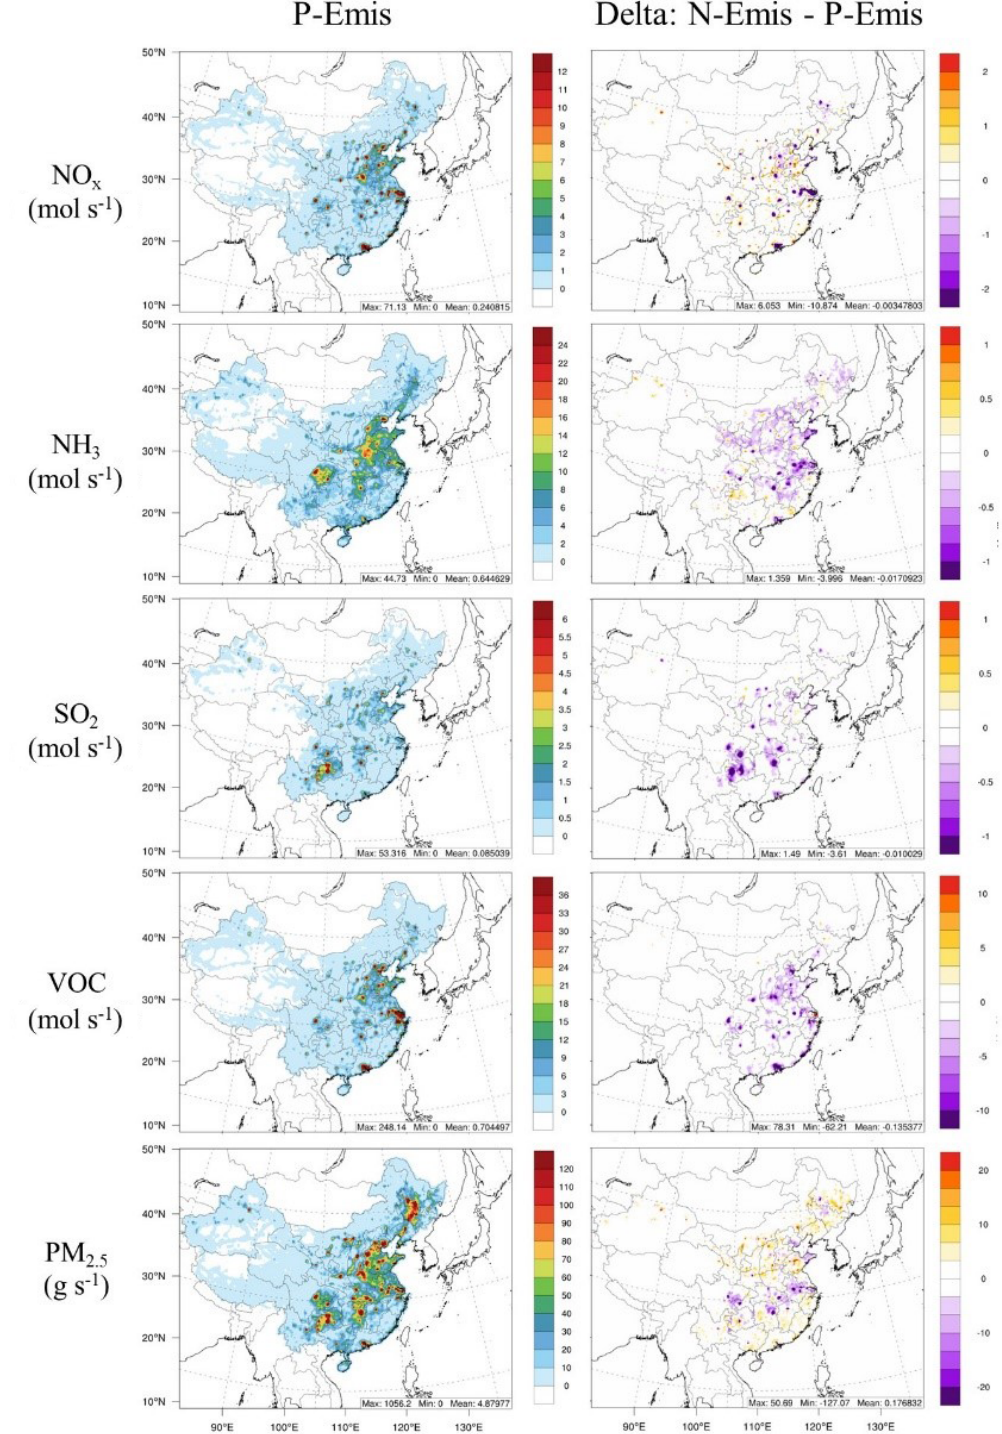
Figure 5. Emission rates of NO x , NH 3 , SO 2 , VOCs and primary PM 2 . 5 in P-Emis and their changes in N-Emis.